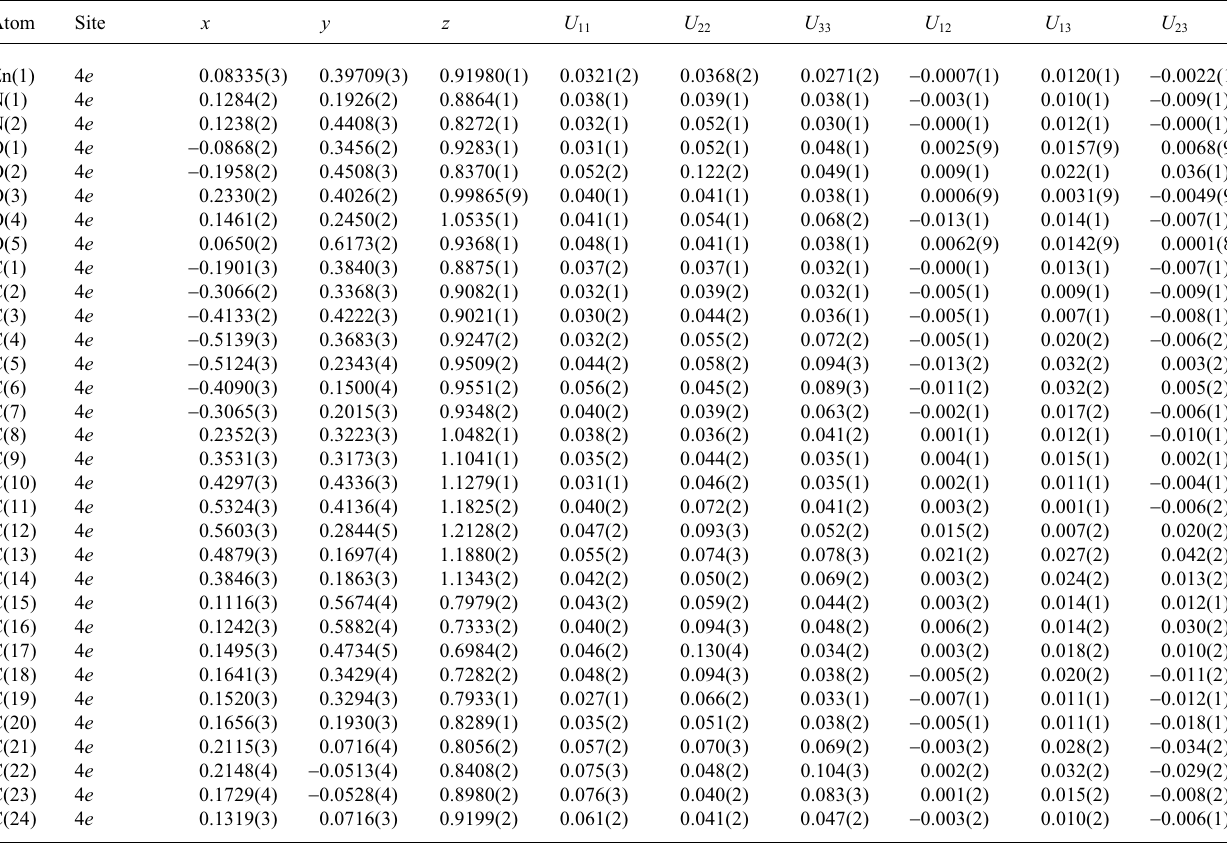
Table 3. Atomic coordinates and displacement parameters (in Å 2 )